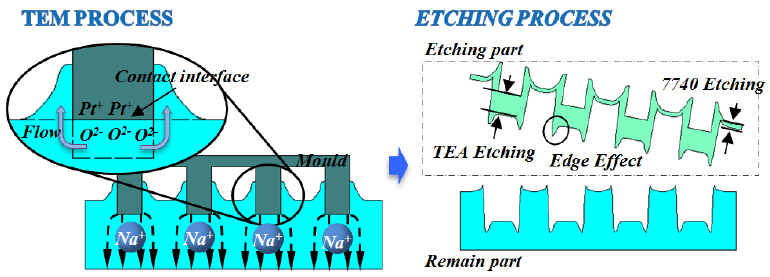
Figure 10. Schematic of two of edge effects in TEM etching.